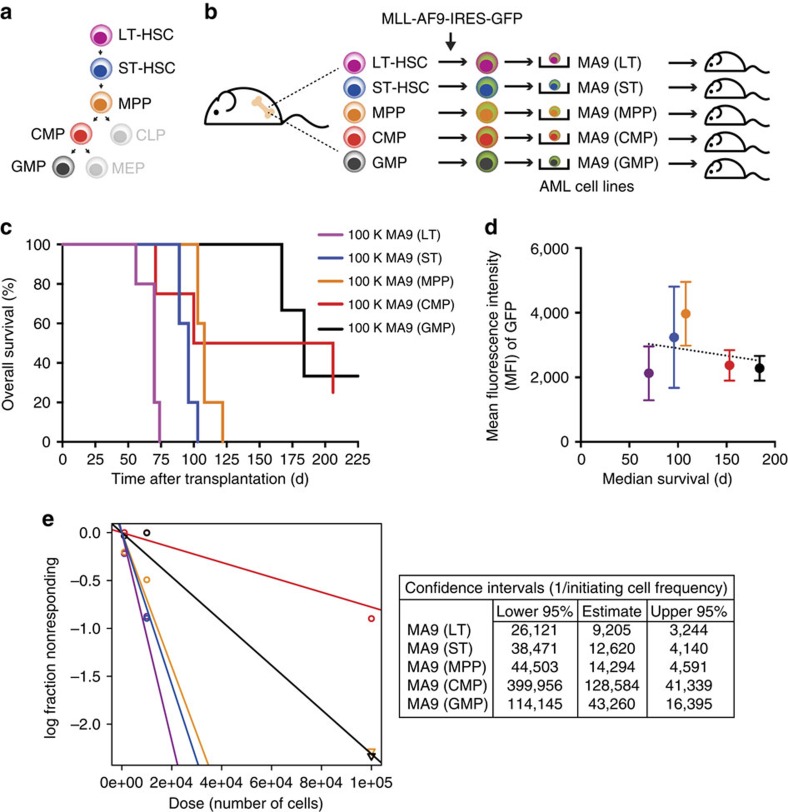
Cell of origin determines potency of in vitro-derived MA9-driven AML.(a) Schematic diagram of the primitive haematopoietic hierarchy. Colour code: purple for long-term HSCs (LT-HSC), blue for short-term (ST)-HSC, orange for multipotent progenitors (MPP), red for common myeloid progenitors (CMP), black for granulocyte macrophage progenitors (GMP). (b) Schematic diagram of experimental design to test in vitro transformation of distinct cells of origin by MA9. (c) Overall survival of mice transplanted with 100 K MA9-transformed cells from distinct cells of origin (n=5 per group). Technical replicates of 5 mice were each transplanted with 100 K cells from one set of cell lines. Trend and significance were replicated once using a set of independently derived cell lines. Log-rank test; P<0.0001. (d) Correlation between mean fluorescence intensity (MFI) of GFP in leukaemia cell lines and median survival (days) of mice transplanted with these lines (n=5 per group). Centre values indicate mean. Error bars indicate s.e.m. Pearson's r=−0.2653, not significant. (e) Limiting dilution analysis of leukaemia cell lines from distinct cells of origin (n=5 per group, per cell dose). Technical replicates of five mice were each transplanted with 100 K, 10 K or 1 K cells from one set of cell lines. Trend and significance were replicated once using a set of independently derived cell lines. Confidence intervals (1 per initiating cell frequency) were calculated with ELDA software50. Pearson's χ2-test; P=0.00145.